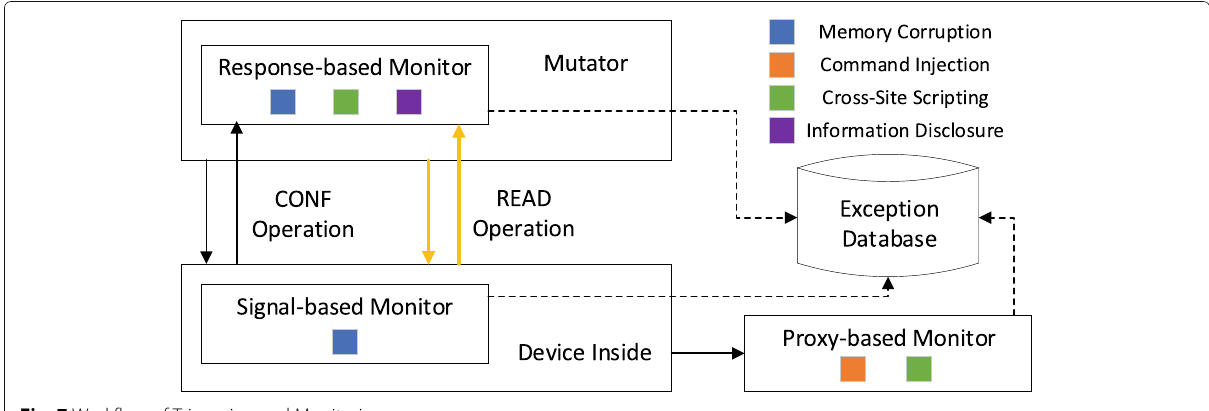
Fig. 7 Workflow of Triggering and Monitoring